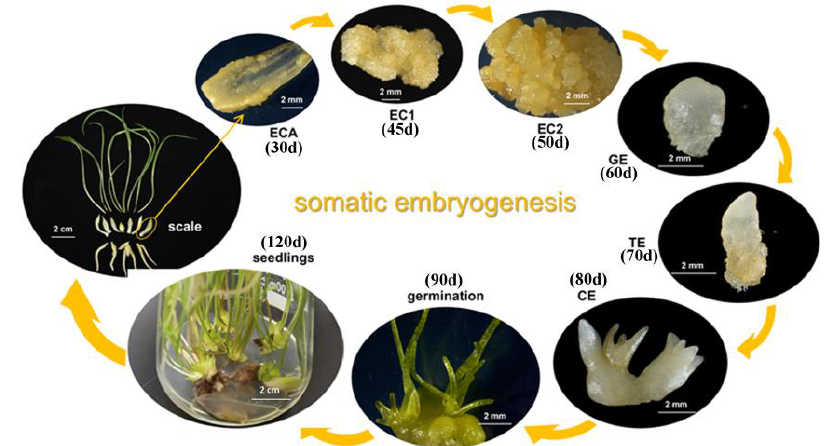
Figure 11. Schematic illustrating the different stages of somatic embryo development in Lilium pumilum . ECA, embryonic cells appear; EC1, early proembryo; EC2, late proembryo; GE, globular embryo; TE, torpedo embryo; CE, cotyledon embryo. The time scales of somatic embryogenesis at different stages are shown in the picture. d, days.